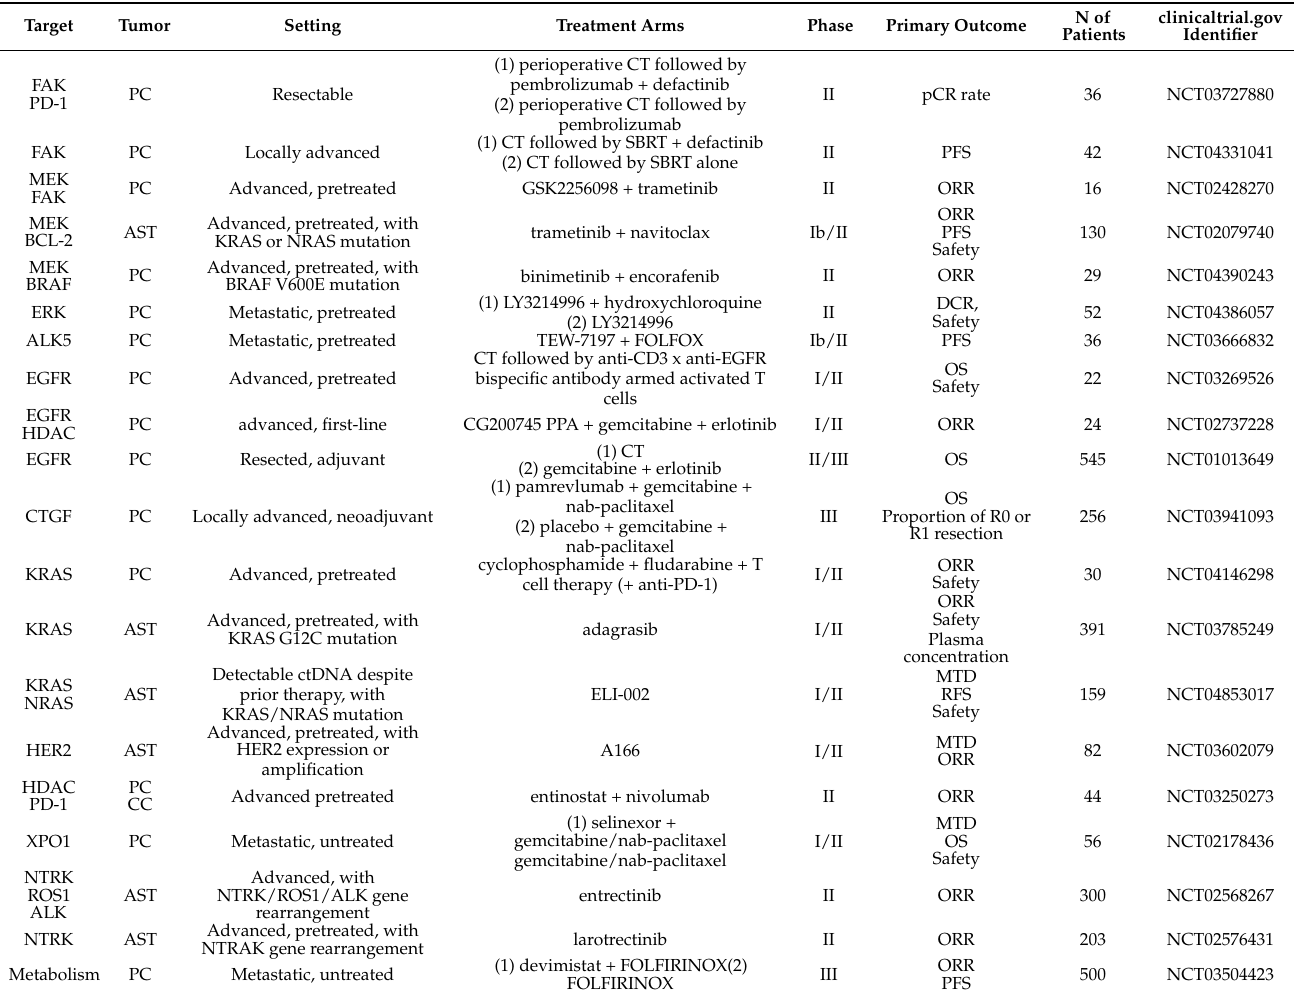
Table 2. Ongoing trials evaluating activity and efficacy of novel molecules acting on different targets in PC (Clinicaltrials.gov last accessed 10 June